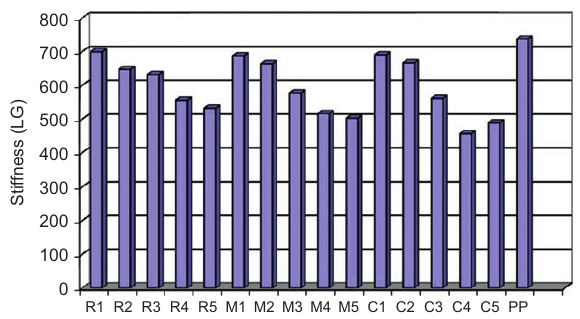
Figure 12 Normalized absorbed energy results for composites. Figure 13 Stiffness results for